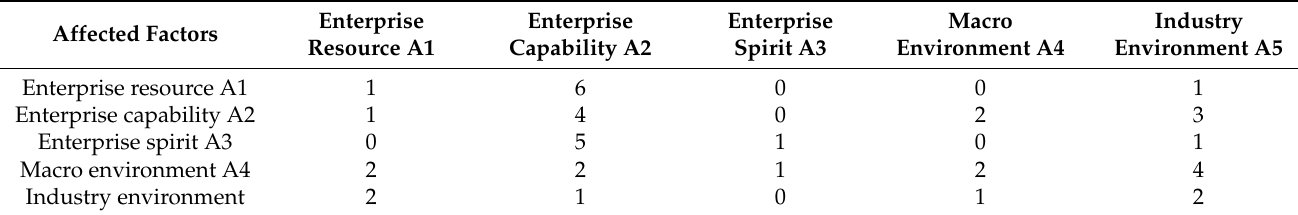
Table 4. The correlation of first-level indicators.